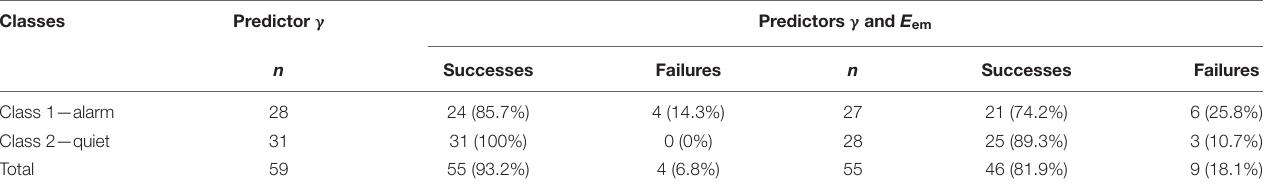
TABLE 1 | Results of the application of the GP technique to forecasting the periods of increased EQ hazard level in caucasus using predictor γ or predictors γ and E em jointly; n is the number of a given class situation—alarm or quietness. Classes Predictor γ Predictors γ and E em n Successes Failures